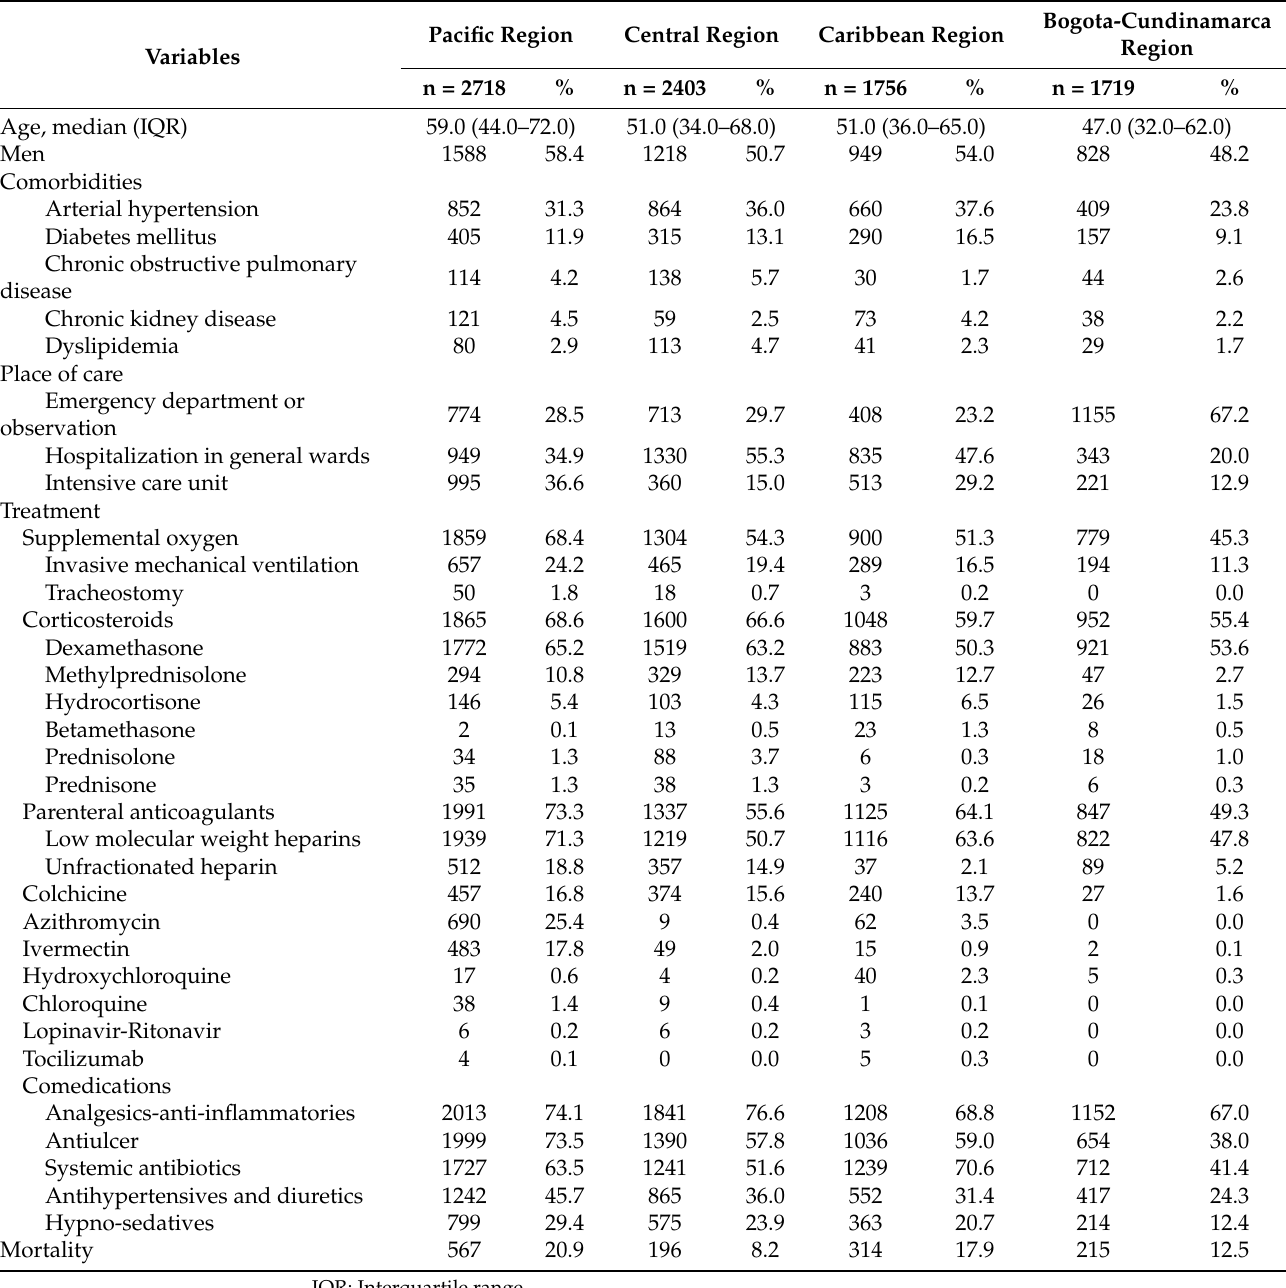
Table 3. Comparison of some sociodemographic, clinical and pharmacological variables by geo- graphic regions, in a group of patients with a confirmed diagnosis of SARS-CoV-2 infection,